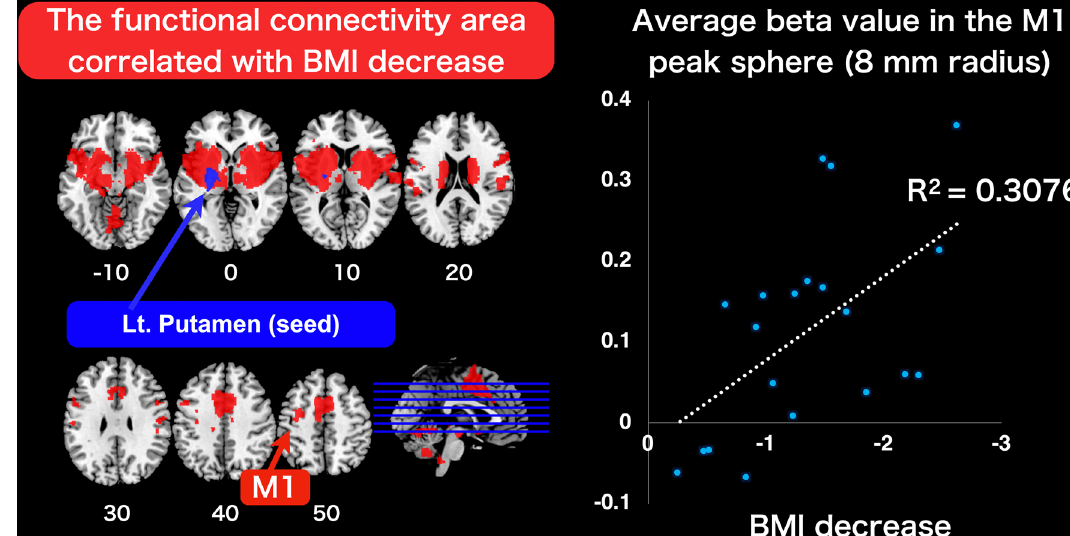
Figure 5. The functional connectivity area correlated with BMI decrease in Time2. The functional connectivity area (shown in red) that correlated with a decrease in BMI, seeding the left putamen cluster (shown in blue) at Time2, is shown. The M1 cluster is indicated by a red arrow. Using the eigenvariate function in SPM, we extracted the average beta value (as the functional connectivity value) in the sphere of an 8-mm radius (16-mm diameter) located at the peak of the left M1 cluster, based on our hypothesis testing the representation within the motor loop of boxers. The right scatter graph indicates a significant correlation (R 2 = 0.3076, [ p = 0.011]) between the decrease in BMI and the average beta value within the sphere of the left M1 cluster at Time2. BMI, body mass index; M1, primary motor cortex; SPM, statistical parametric In a regression analysis between the BMI reduction data and functional connectivity data for seeding the putamen cluster at Time2, boxers showed significant BMI decreases covaried with functional connectivity between the putamen and brain regions, such as the left insula [top peak = (− 40, 2, 12); cluster FWE-corrected p < 0.001; number of voxels = 8897], right insula [top peak = (36, 6, 8); cluster FWE-corrected p < 0.001; number of voxels = 7927], cingulate gyrus (dorsal part of the anterior cingulate cortex) [top peak = (36, 6, 8); cluster FWE-corrected p < 0.001; number of voxels = 2463], and left M1 cluster [top peak = (− 30, − 4, 50); cluster FWE- corrected p = 0.002; number of voxels = 293) (Fig. 5 and Table 4).